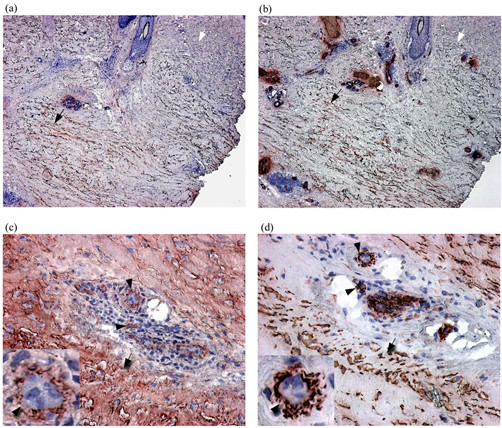
Expression of ED-A correlates specifically with myofibroblasts in dcSSc skin. (a,c) Serial cryosections were stained with antibodies against ED-A FN and (b,d) α-SMA. Both ED-A FN ((a,c) arrows) and α-SMA+ve myofibroblasts ((b,d) arrows) were predominant in the lower reticular dermis of dcSSc skin. Note the absence of ED-A FN ((a) white arrow) and α-SMA+ve myofibroblasts ((b) white arrow) in the papillary dermis. In addition, immunostaining for ED-A FN was also detected in the wall of microvessels ((c) inset, arrowheads) correspondingly containing α-SMA-expressing pericytes ((d) inset, arrowheads). Original magnification (a,b) × 10, (c,d) × 20, inset (c,d) × 40. α-SMA, alpha smooth muscle actin; dcSSc, diffuse cutaneous systemic sclerosis; ED-A FN, ED-A splice variant of fibronectin.